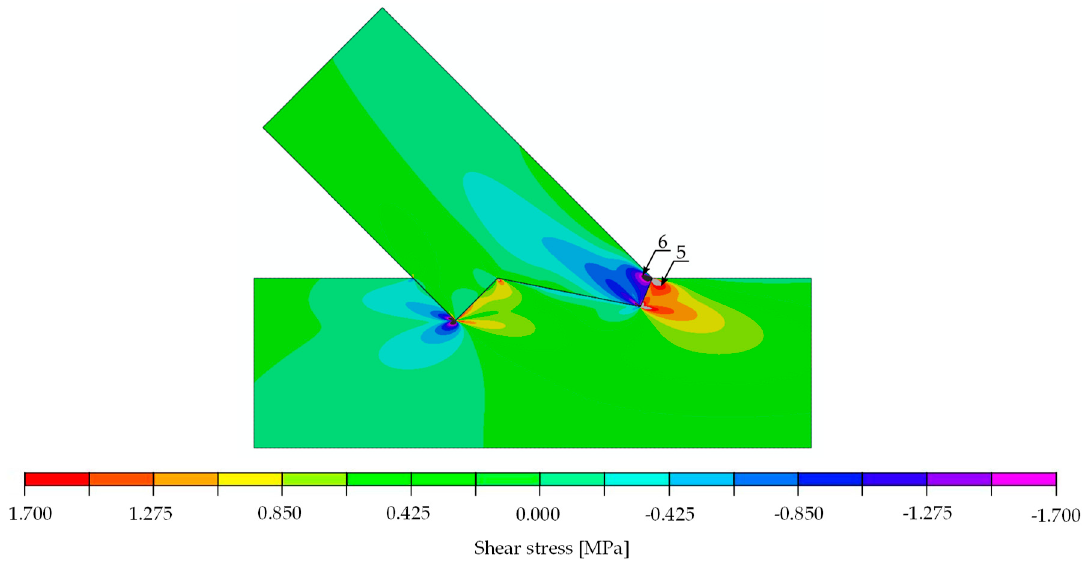
Figure 22. Double-step joint FEM modelling - shear stress [MPa]. Force 30 kN.